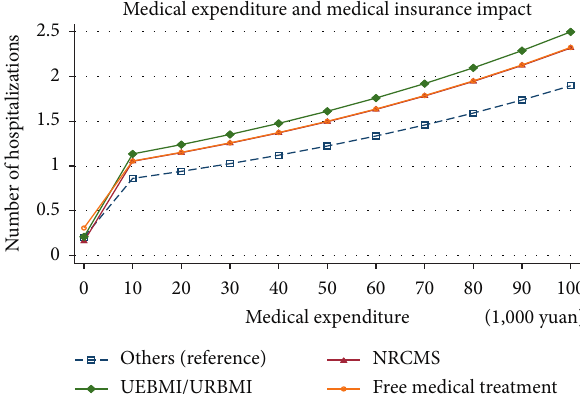
Figure 6: Medical expenditure and medical insurance impact.